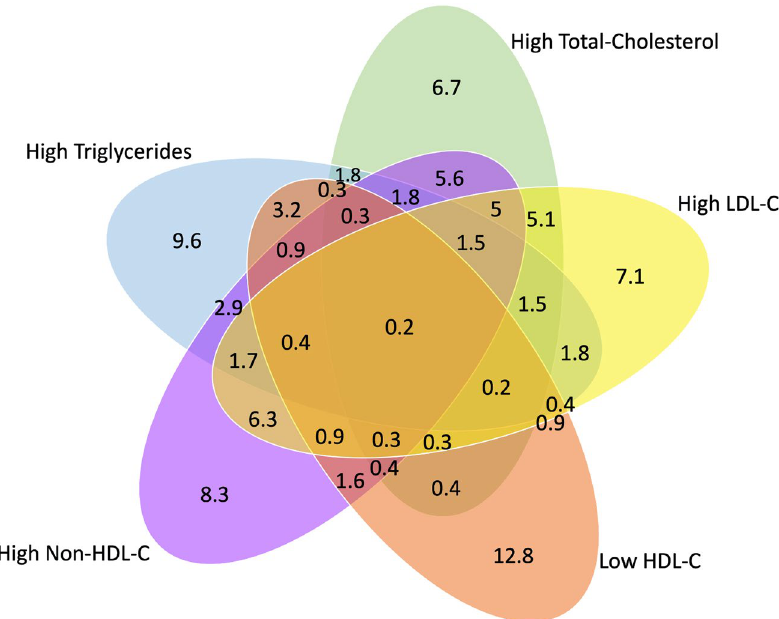
Figure 5. Venn diagram comparing the prevalence of single and multiple lipid abnormalities in adolescents in Saudi Arabia. The values demonstrate the prevalence (%) of abnormally elevated levels of Total-Cholesterol, LDL-C, Non-HDL-C, and Triglycerides, and lower levels of HDL-C. The overlap of sets represents the rates of adolescents meeting more than one abnormality (PowerPoint version